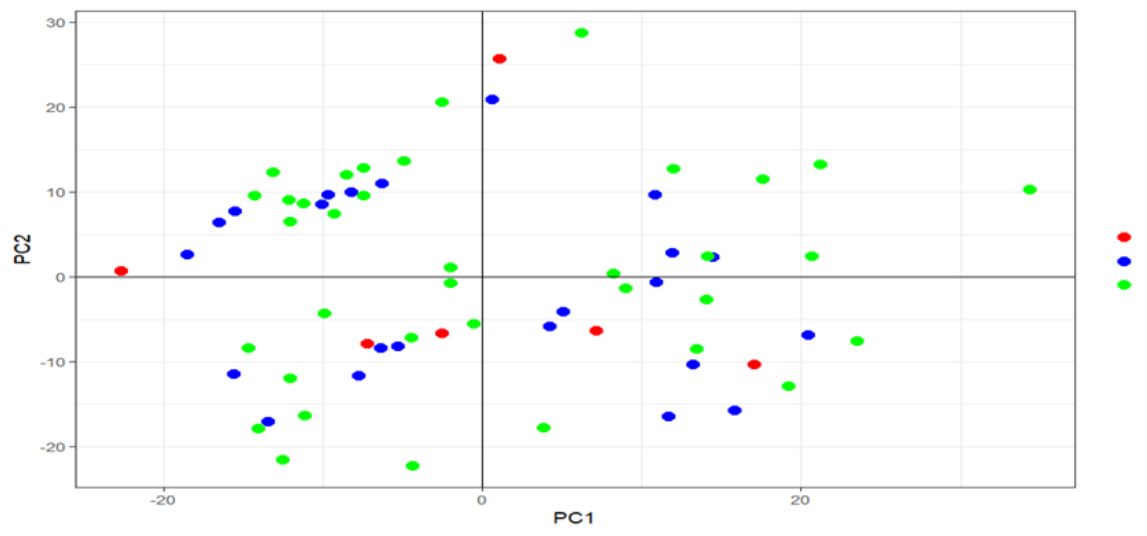
Figure 4. PCA plot of serum samples. Plot of PC 1 vs. PC 2.